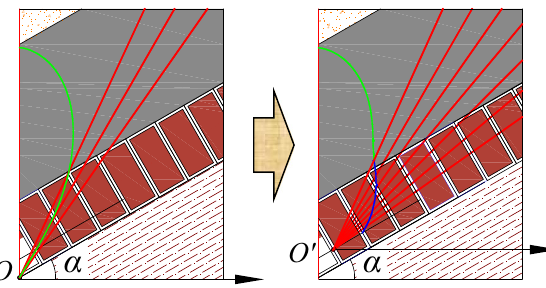
Fig. 8 Changes in the lines tracing particle motion in the trace- variation zone